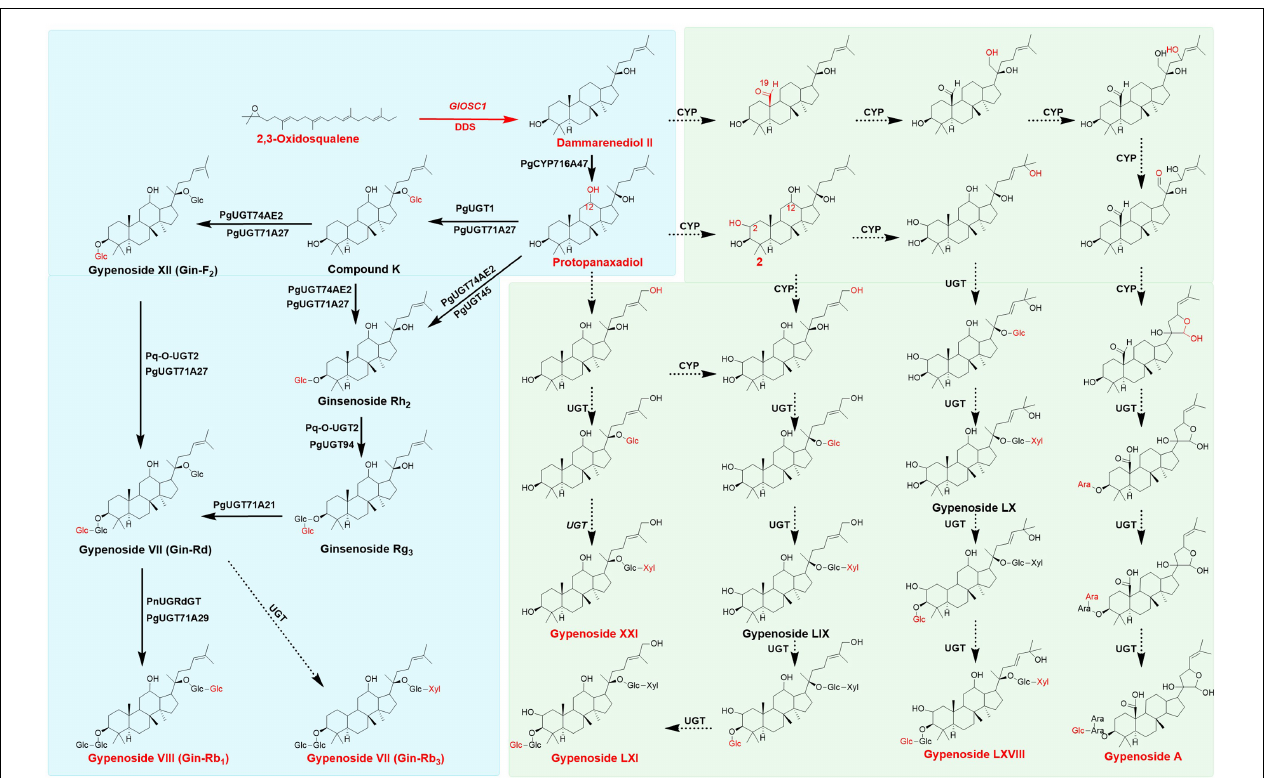
FIGURE 1 | Proposed Biosynthesis pathway of gypenosides and ginsenosides, the main triterpenes were colored in red, the broad arrows presented the enzymes already identified, dotted arrows presented the assumed enzymes in gypenosides analysis. Pathways in green background only found in Gynostemma plants, pathways in blue back ground could appear both in Gynostemma plants and Panax plants.